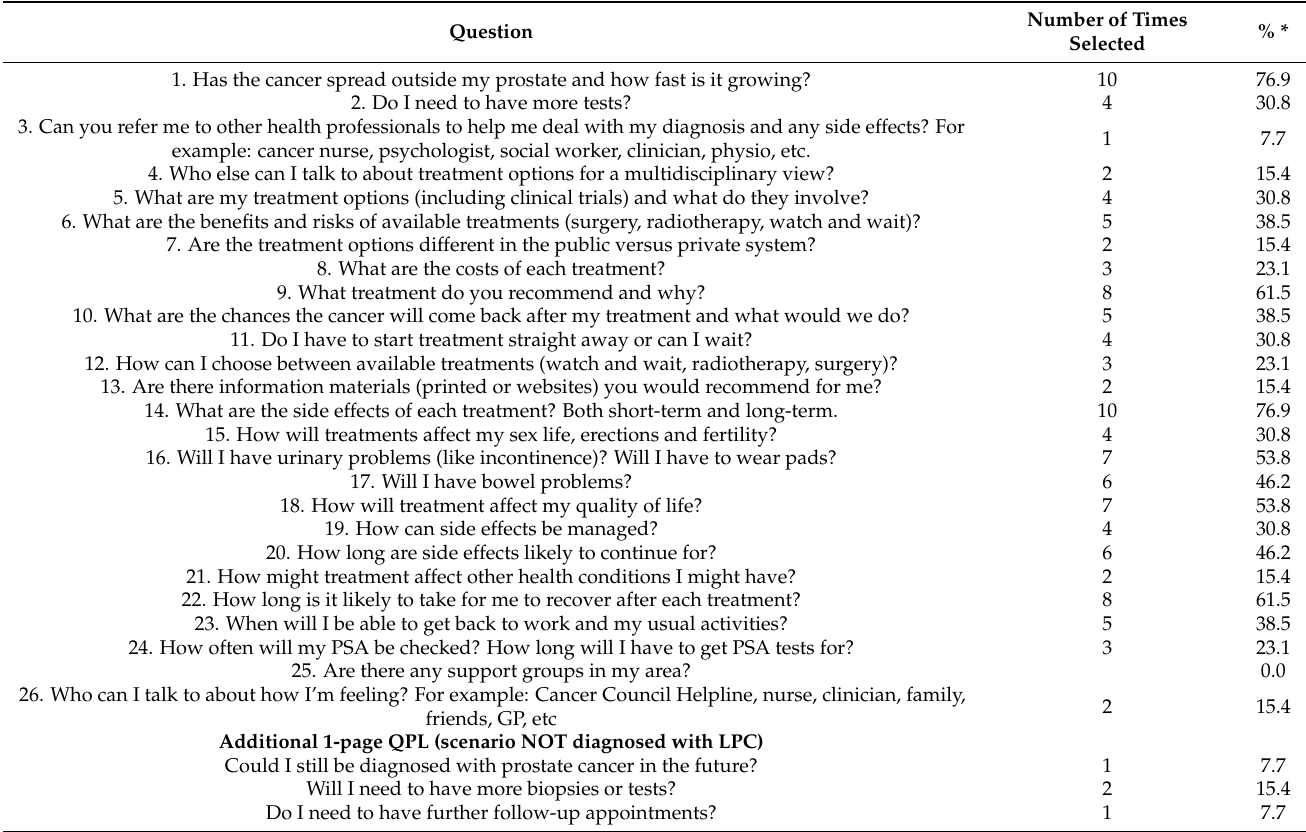
Table A1. Most frequently selected